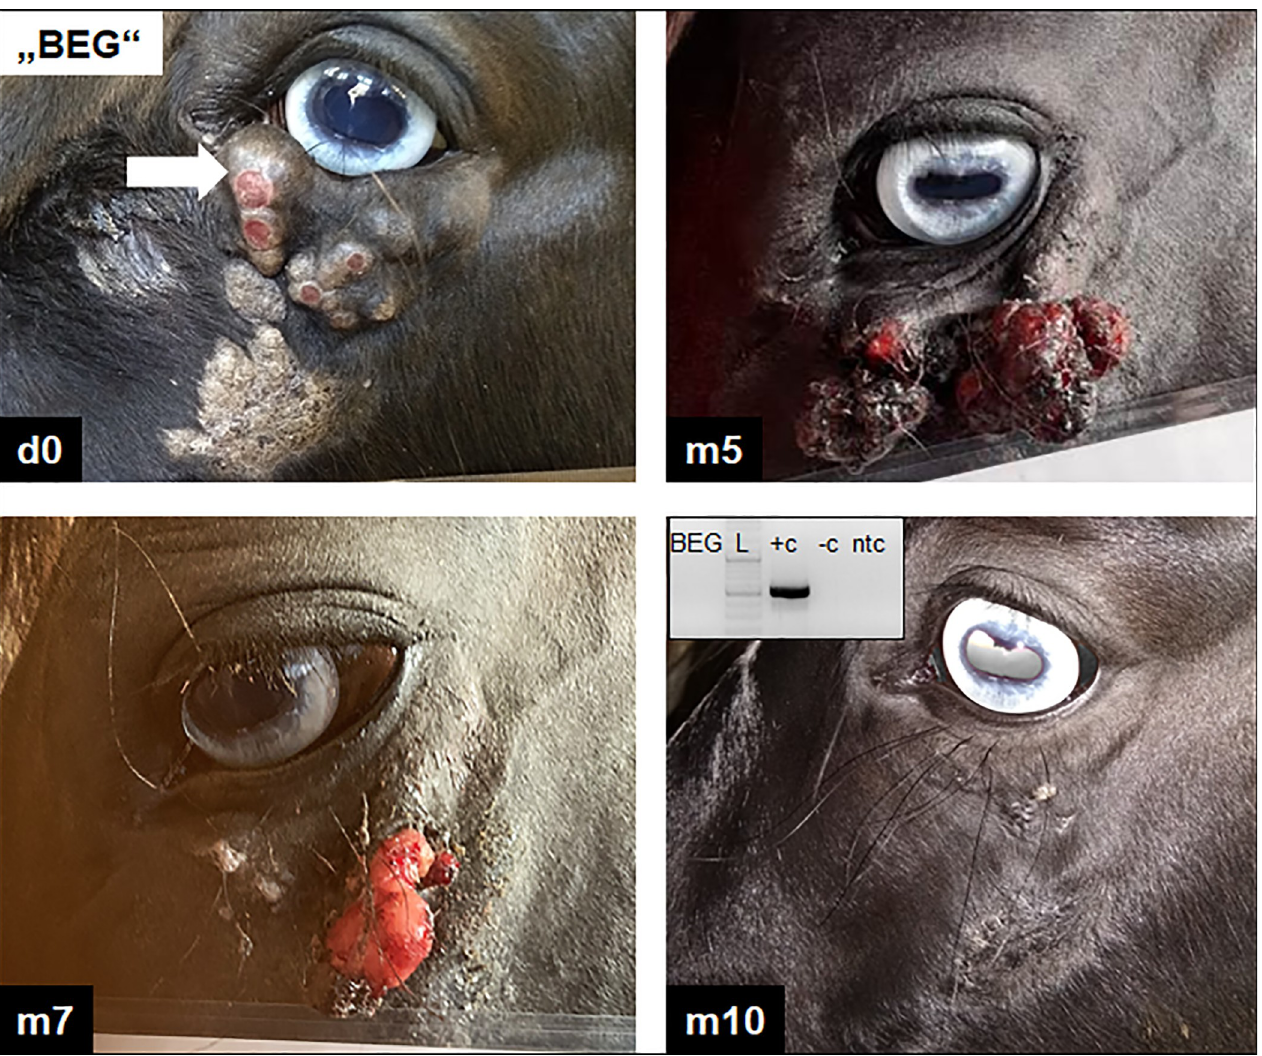
Fig 6. Intratumoural injection with iNSA/E6E7 equ on d0 , d28 , d86 led to tumour regression and no BPV1 DNA was detectable anymore from the tumour site. A mare (BEG) suffering from periocular mixed sarcoids (fibroblastic, nodular and verrucous components) shows complete tumour regression 10 months after intratumoural injections (white arrow indicates injection site) with iNSA/E6E7 equ on days 0, 28 and 86. Importantly, BPV1 E5 PCR from DNA of crusts collected from scarified skin (month 10) scored negative (see inserted gel photo; BEG: patient DNA; L: GeneRuler DNA Ladder mix [ThermoScientific]; +c: sarcoid DNA as positive control: -c: equine intact skin DNA as negative control; ntc: sterile water as no-template control); d0: day 0; m5: month 5; m7: month 7; m10: month 10.